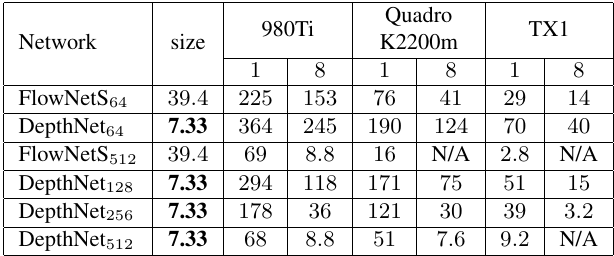
Table 4. Size (millions of parameters) and Inference speeds (fps) on different devices. Batch sizes are 1 and 8 (when applicable).